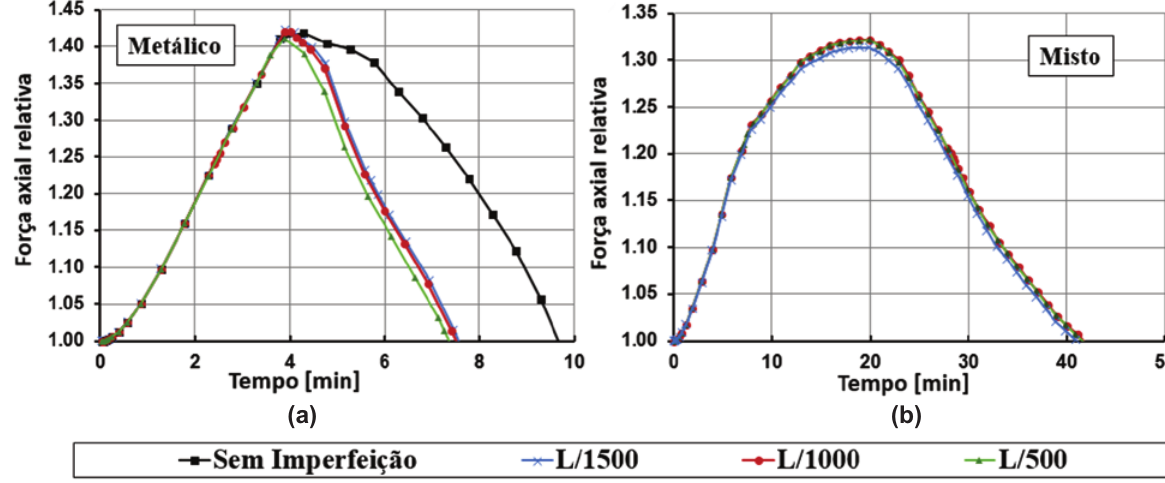
Variação da força axial relativa para diferentes valores de imperfeição geométrica nos